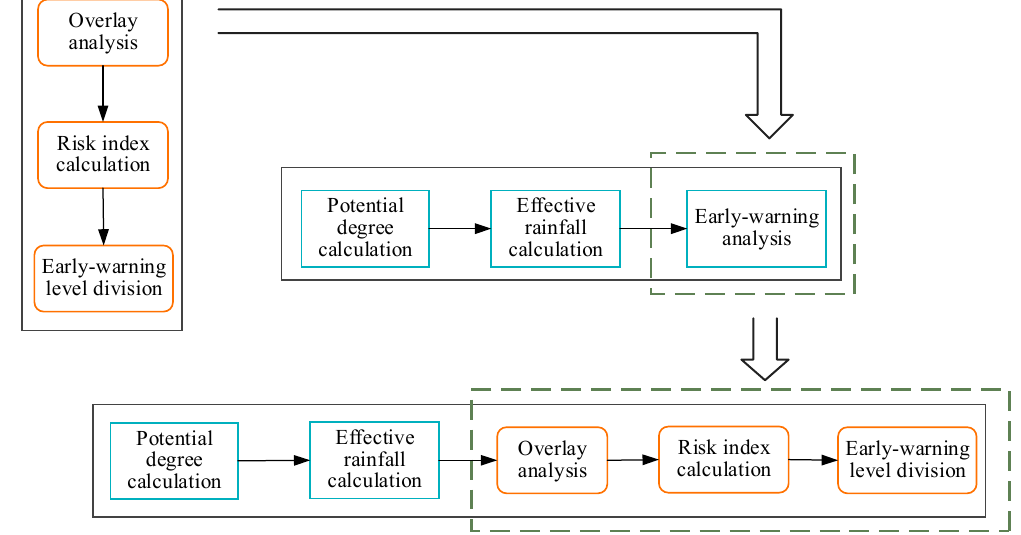
Figure 4. An example of task decomposition.